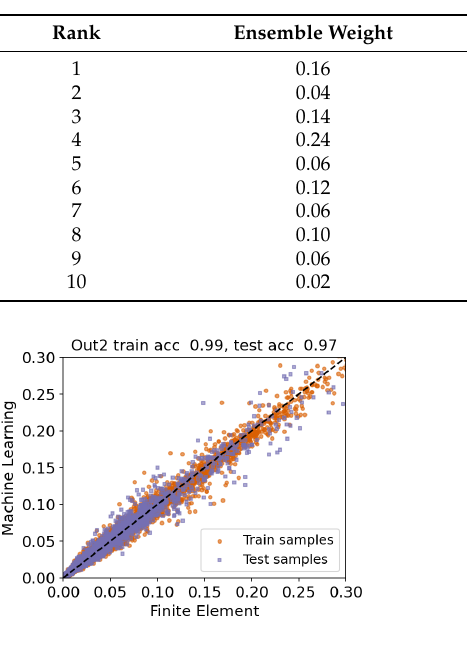
Figure 7. Scenario 1 (Out2): plotting true vs. predicted values for both training and test samples. The available data are split into train/test sets according to Figure 1. We see that the surrogate model performs well on both training and test sets (acc in the title refers to R 2